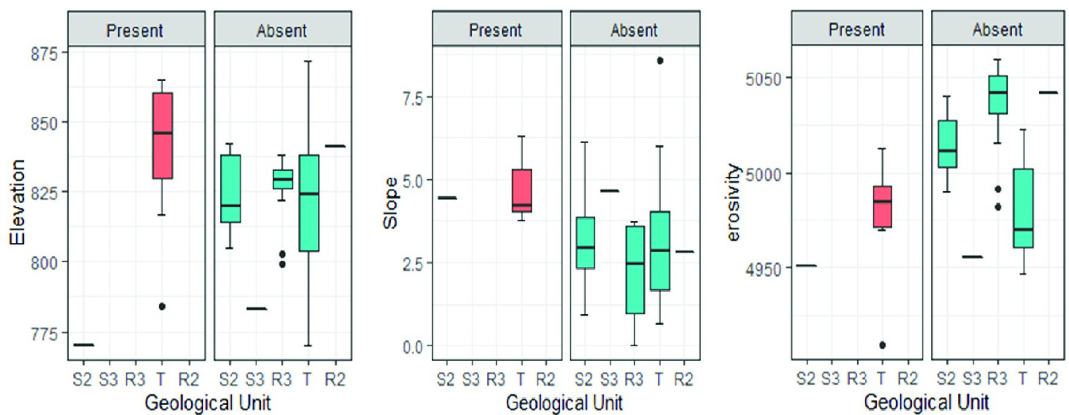
Fig 8. Exploratory statistics: Phase 1 localities. The presence/absence of lithic artefacts as a function of elevation, slope and erositivity by geological unit. grassland or shrubland, according to the 2016 Sentinel 2 landcover data, although field obser- vations suggest they occur in thin miombo forest. Predictor variables tested using regression